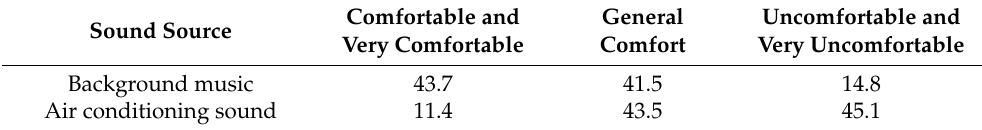
Figure 9. Correlation between subjective loudness, sound comfort, and SPL. Table 4. Acoustic comfort of background music and air conditioning noise